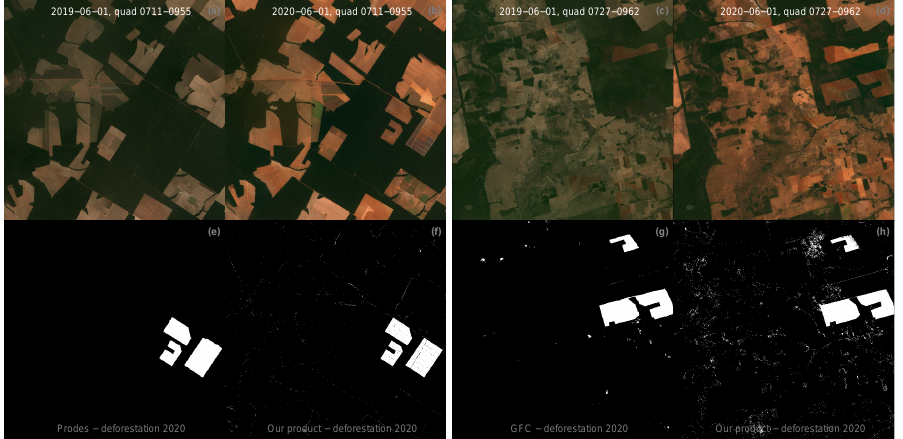
Figure 7. Example of good agreement, i.e., > 90% of intersection, of our product of deforestation with the PRODES data (planet quad 0711-0955) and of our product and GFC’s “tree loss year” data (planet quad 0727-0962) for the year 2020. Planet NICFI quad is